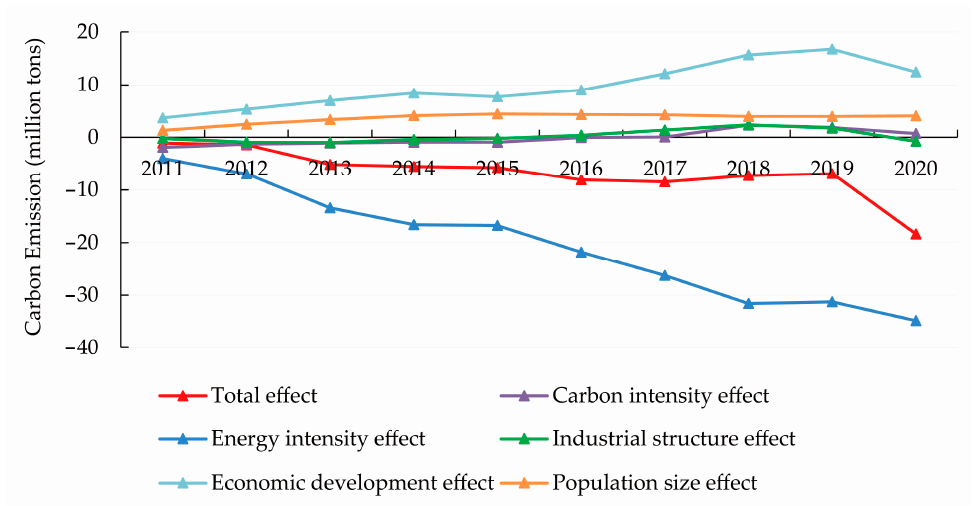
Figure 2. Cumulative contribution of five decomposition factors to carbon emissions.